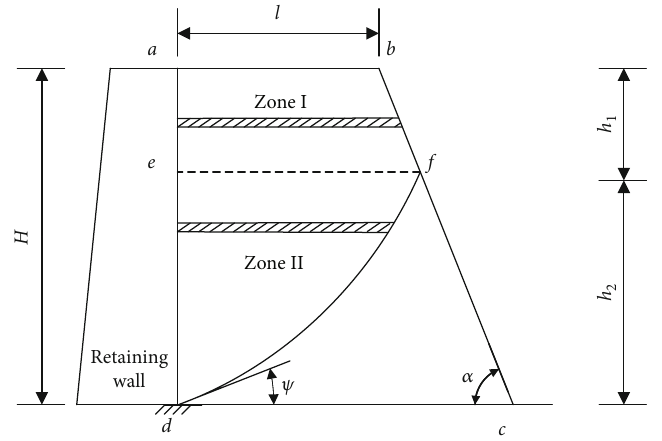
Figure 1: Calculation model of active earth pressure.